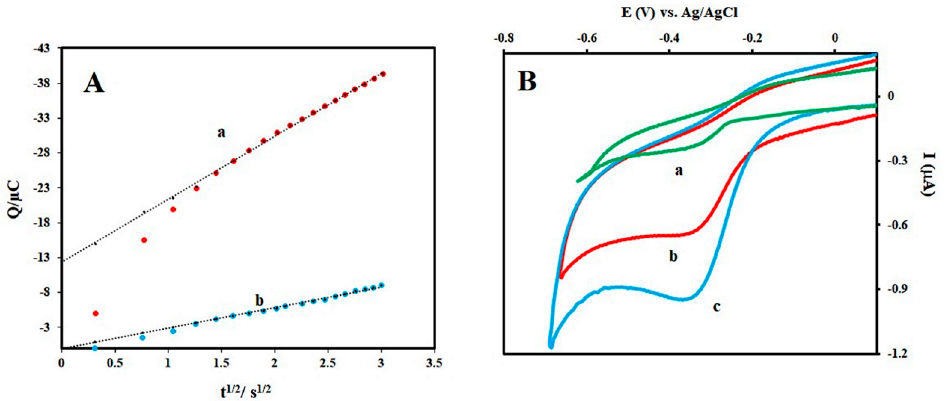
Figure 4. Aptamer surface density and detection feasibility of Trp aptasensor ( A ) Chronocoloumetric curves at Apt / DGNs / Fe 3 O 4 @SiO 2 / DABCO / SPE in a solution of composed of 200 µ M [Ru(NH 3 ) 6 ] 3 + and 0.05 M KCl (a), and containing 0.05 M KCl only (b). ( B ) CV signals of hemin / Apt / DGNs / Fe 3 O 4 @SiO 2